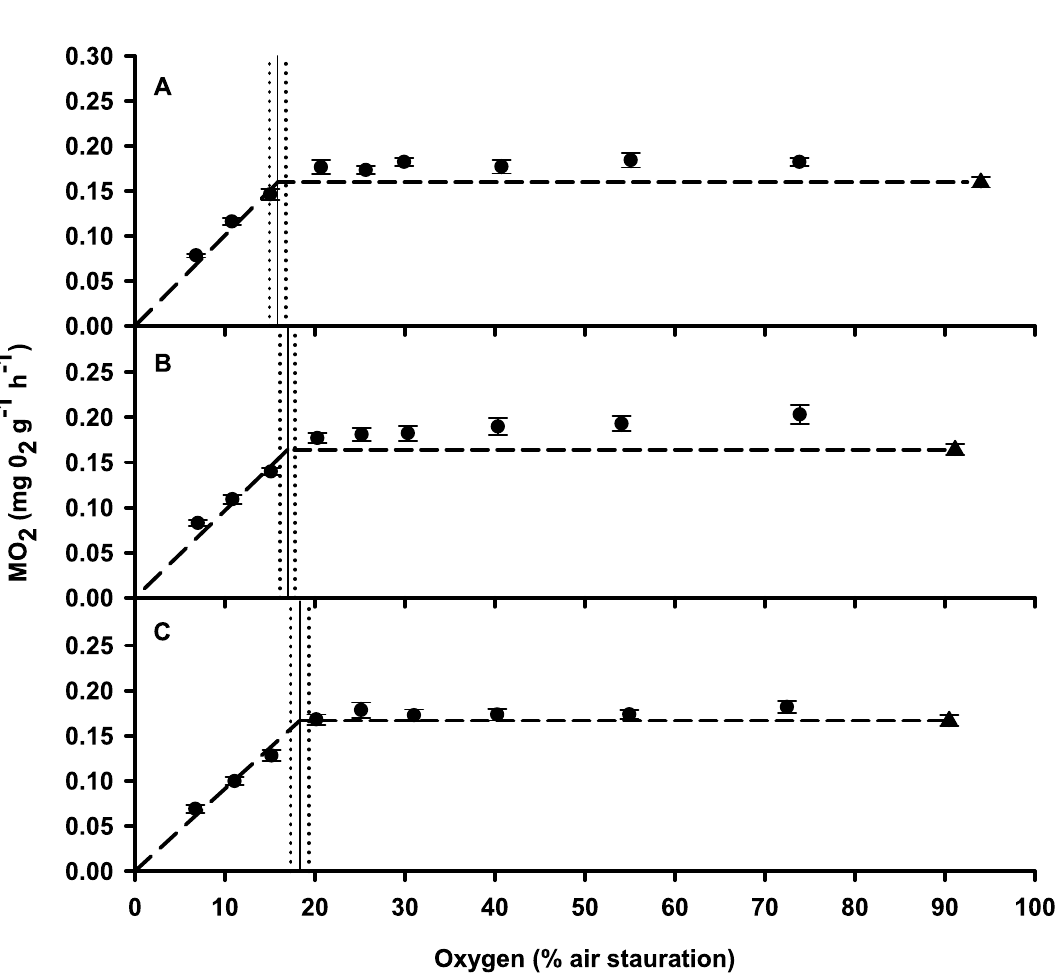
Fig 2. Critical oxygen saturation (S ) and standard metabolic rate (SMR) of Bellapiscis medius following recovery from acute heat crit shock. All values represent mean ± S.E.M. A = control (N = 10), B = +8˚C heat shock (N = 10), C = +10˚C heat shock (N = 8). Triangles show SMR under normoxia, circles show routine _ M _ O under progressive hypoxia exposure, vertical line shows S 2 line shows S S.E.M. The dashed horizontal line shows the break point between oxygen regulation and oxygen conformation and is for crit illustrative purposes only.